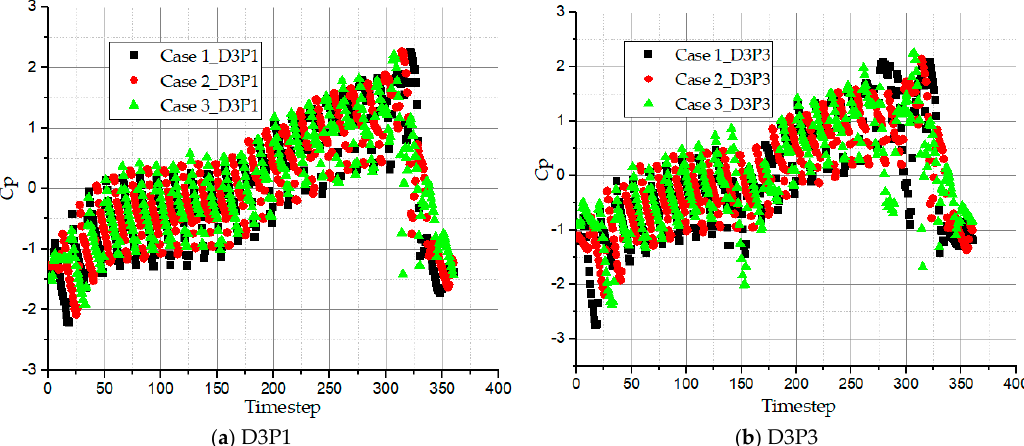
Figure 11. Time domain history of pressure fluctuation coefficient in impeller passage at inflow region for all pump cases.